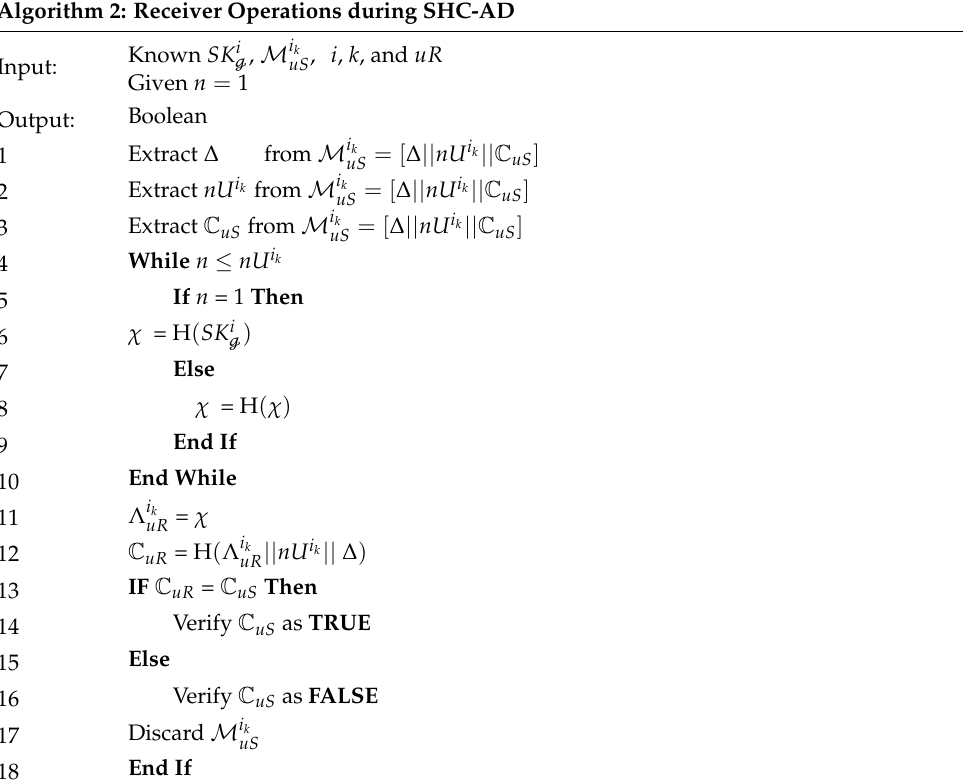
Algorithm 2: Receiver Operations during